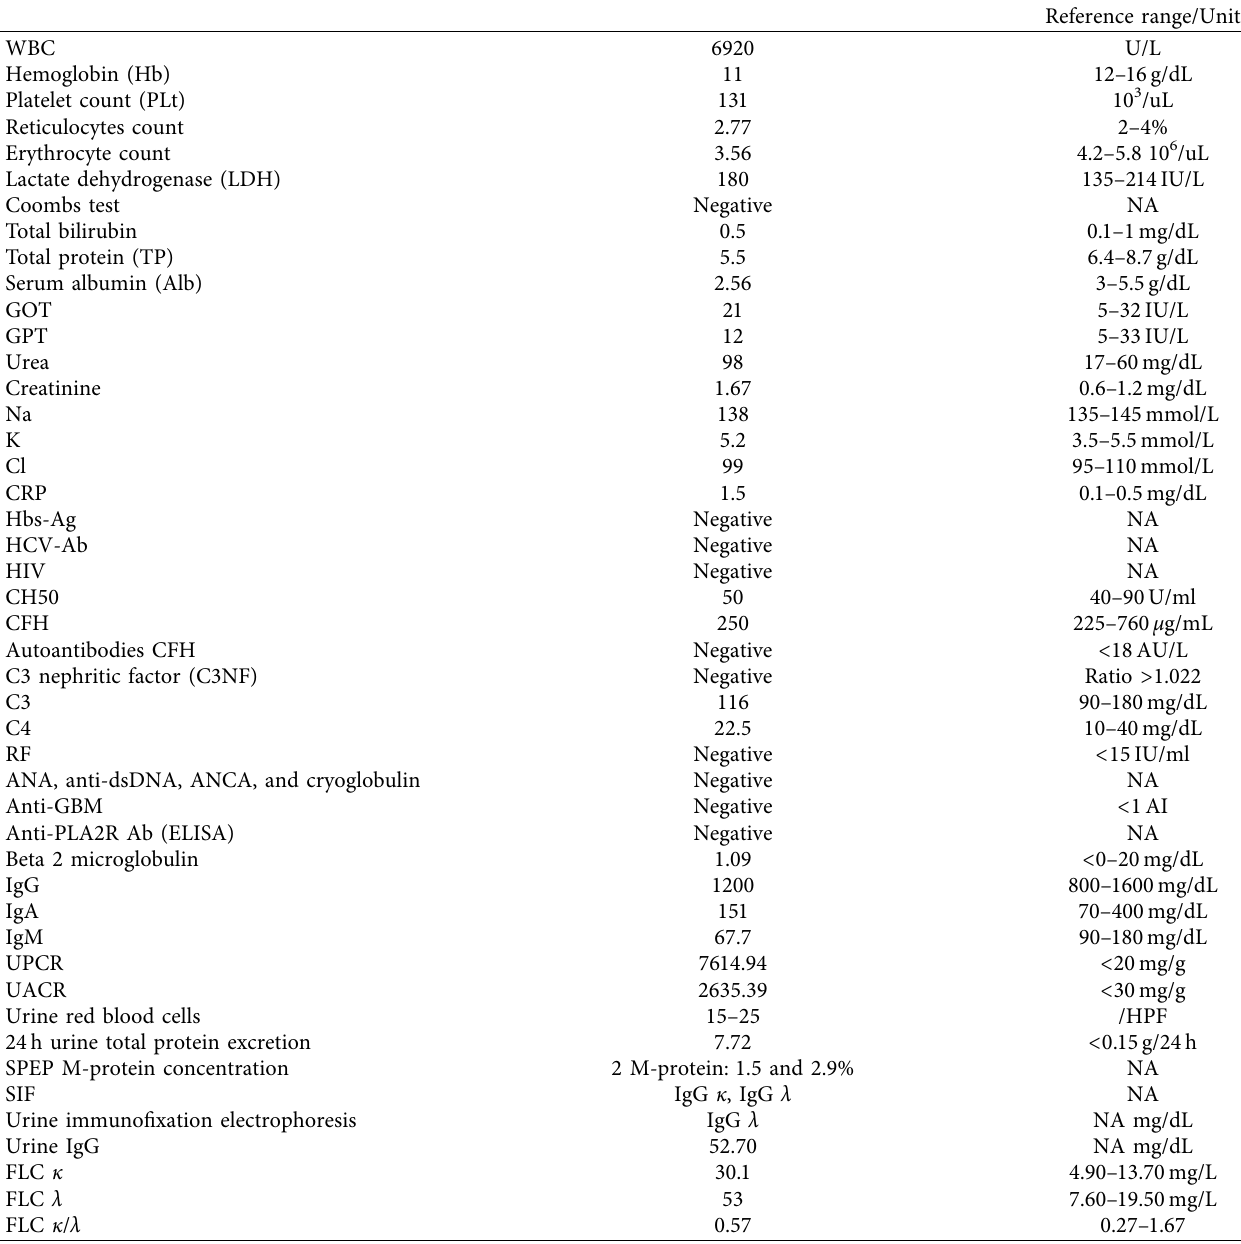
Table 1: Laboratory findings on